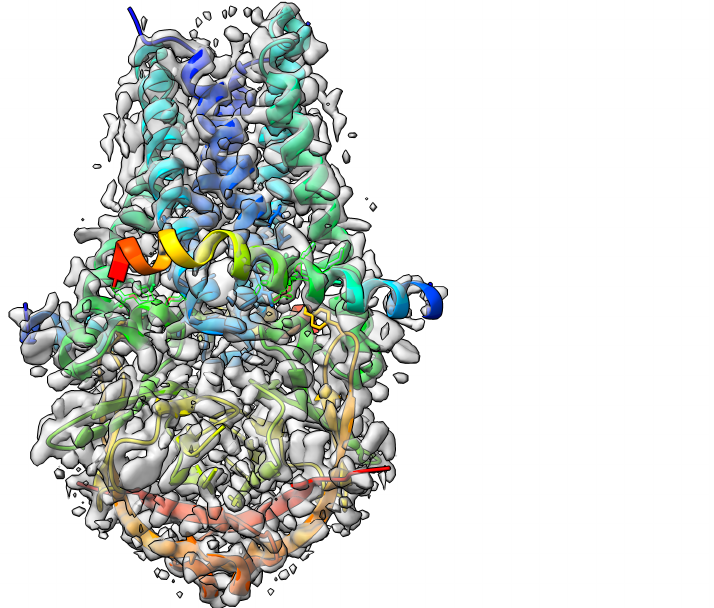
Figure 5. Target 203 (EMD-22898) map-model overlay at the recommended contour 0.7 (10.3 σ ) with T0203EM004_1